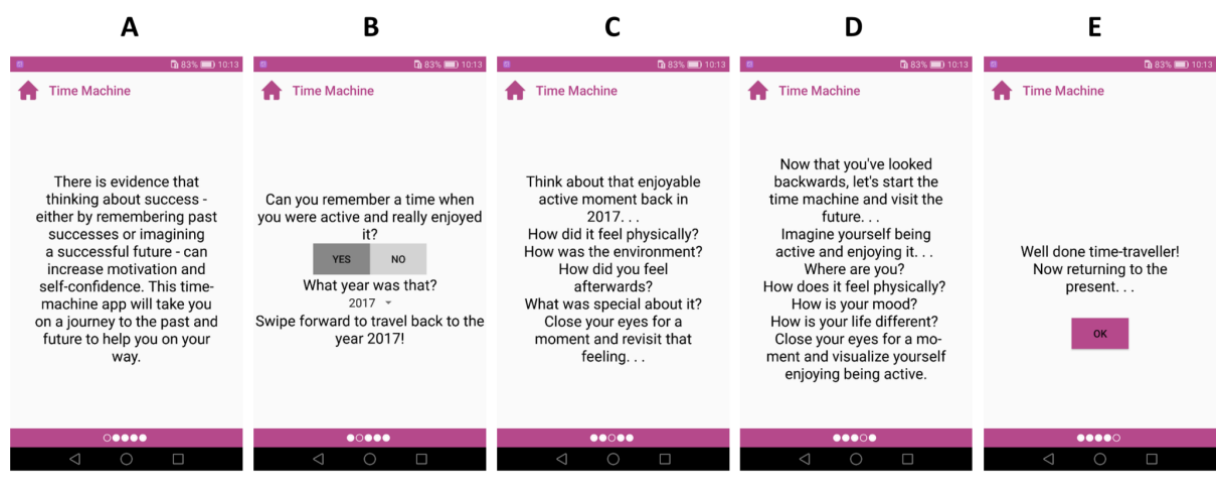
Figure 8. Implementation of the Time Machine tool. Looking back exercises are shown on Screens B and C, and looking forward exercises are shown on Screen